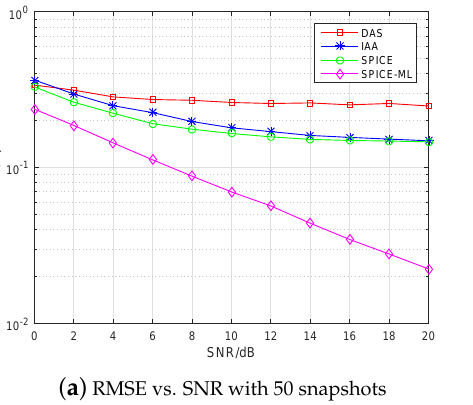
Figure 4. RMSE with independent